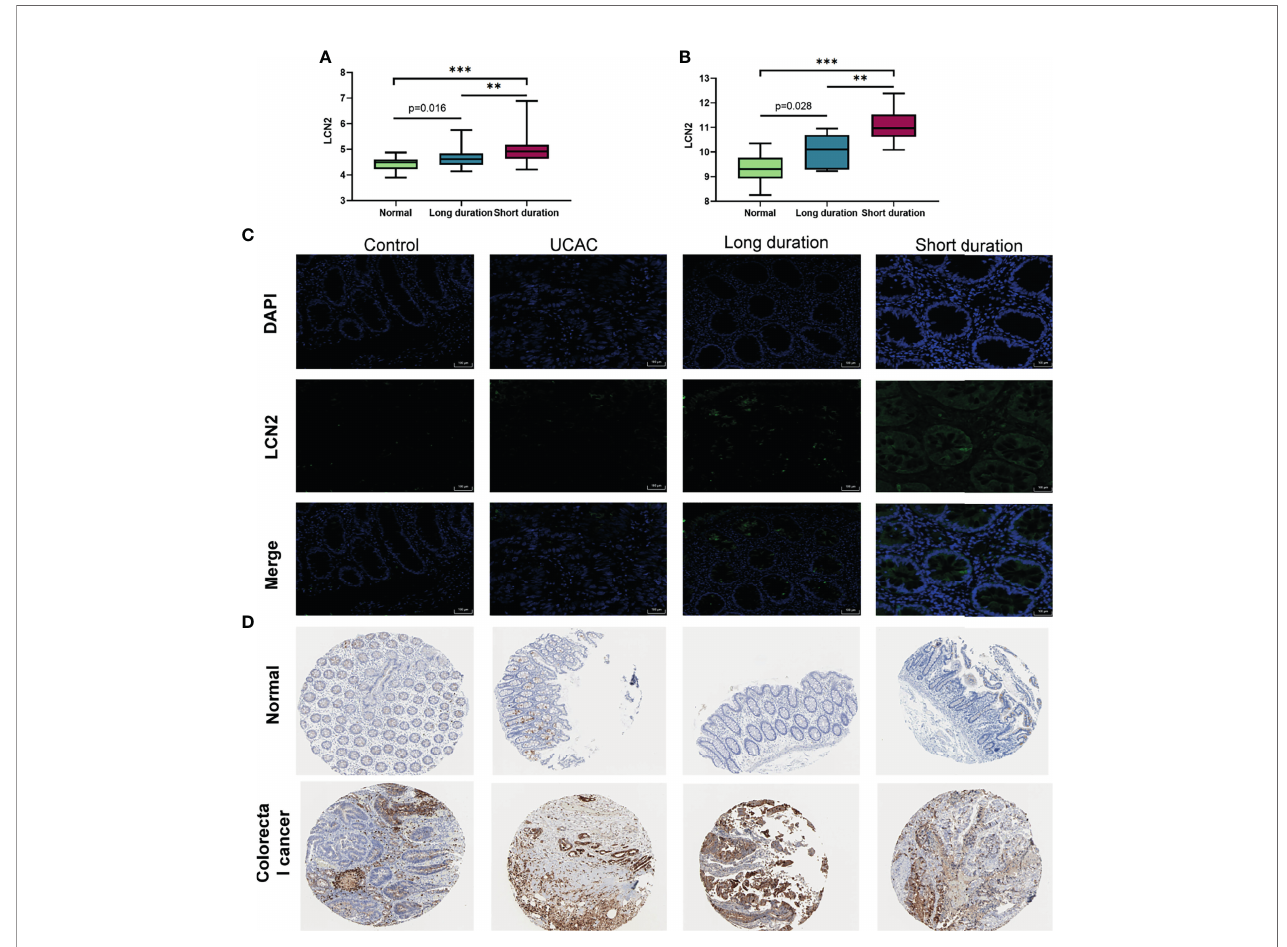
FIGURE 6 | Protein expression veri fi cation in human. (A) Expression levels of lipocalin-2 (LCN2) in colorectal mucosa of GSE11223. (B) Expression levels of LCN2 in blood sample of GSE94648. (C) Immuno fl uorescence of LCN2 in normal, short-duration ulcerative colitis (UC), long-duration UC, and ulcerative colitis-associated carcinogenesis (UCAC). (D) LCN2 in normal colon tissues and colorectal cancer (CRC) from the Human Protein Atlas (HPA) database. ** P < 0.01, *** P <